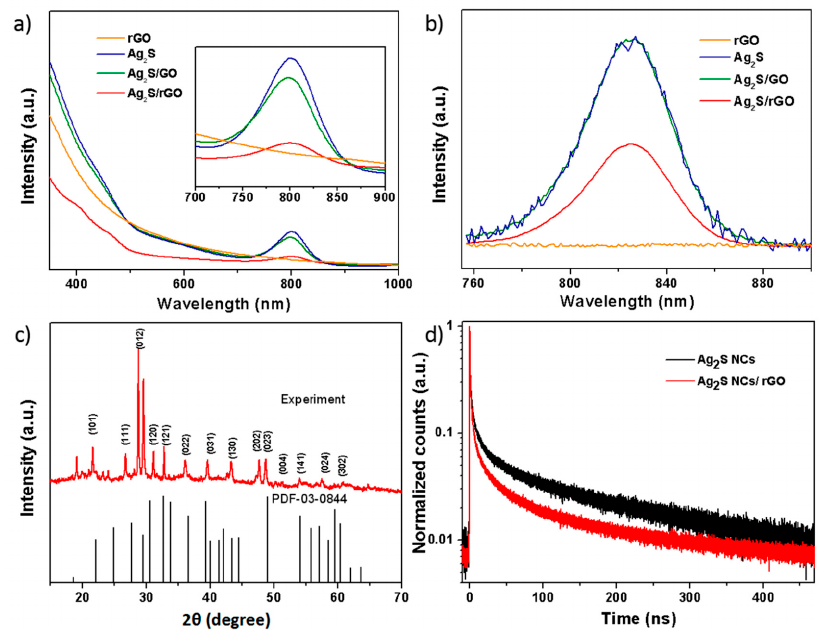
Figure 2. Optical and di ff raction properties of the Ag 2 S / rGO composite series. ( a ) UV-Vis absorbance spectra of Ag 2 S / rGO composite series. ( b ) Photoluminescence spectra of the series at an excitation wavelength of 400 nm. ( c ) XRD patterns of the Ag 2 S / rGO composite. ( d ) Normalized time-resolved photoluminescence (PL) spectra recorded at the PL peak for the Ag 2 S nanocrystals and Ag 2 S / rGO composite.